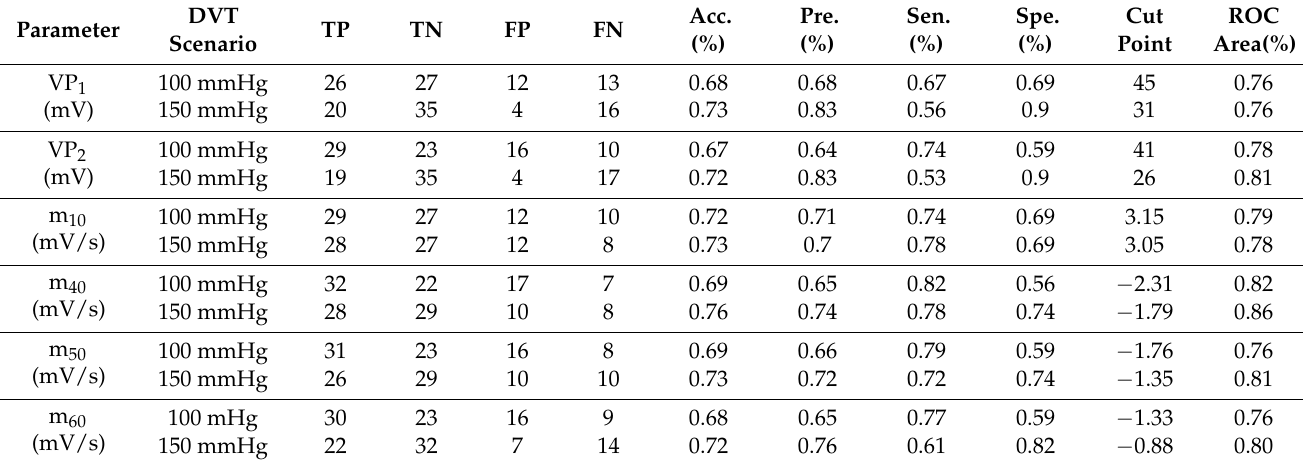
Table 4. The fusion matrix, performances, cut points, and receiver operating characteristic (ROC) areas of six parameters. TP is the true positive, TN the true negative, FP the false positive, and FN the false negative.